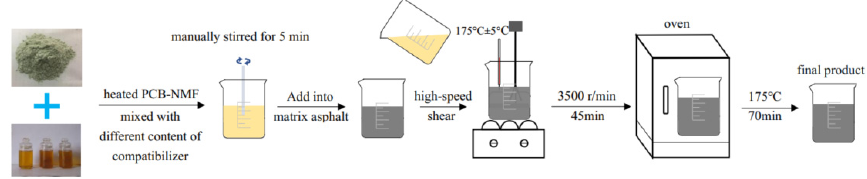
Figure 1. PCB-NMF asphalt preparation process.